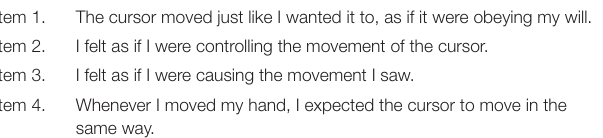
TABLE 1 | Questionnaire adapted from the SoA items from Caspar et al. (2015).